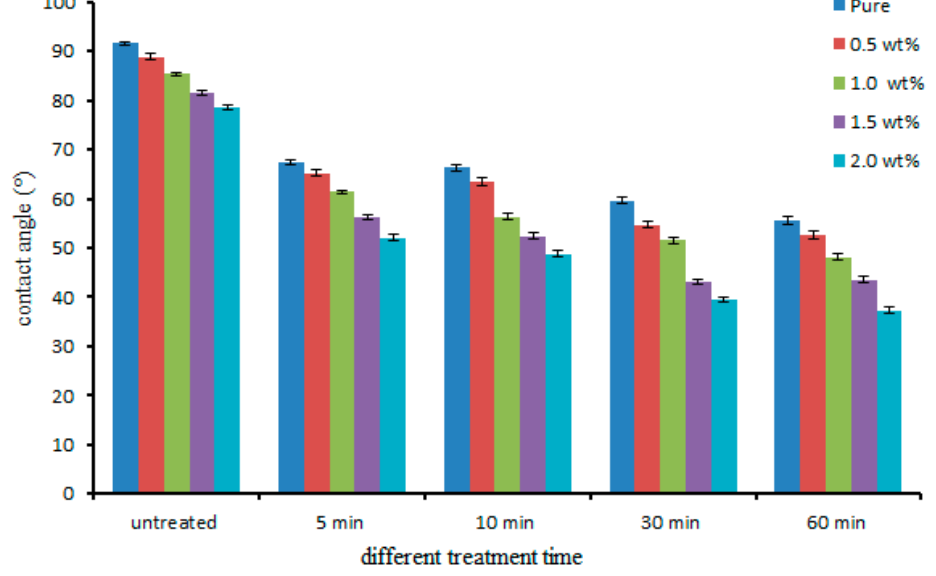
Figure 2. Wettability of nanocomposites before and after plasma treatment at different time exposures.